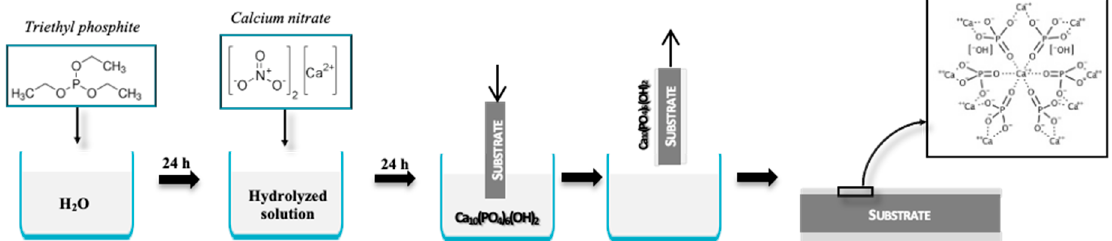
Figure 3. Schematic representation of the sol-gel dip-coating process used by Domínguez-Trujillo [52] to obtain hydroxyapatite sol-gel coating on porous titanium substrates.